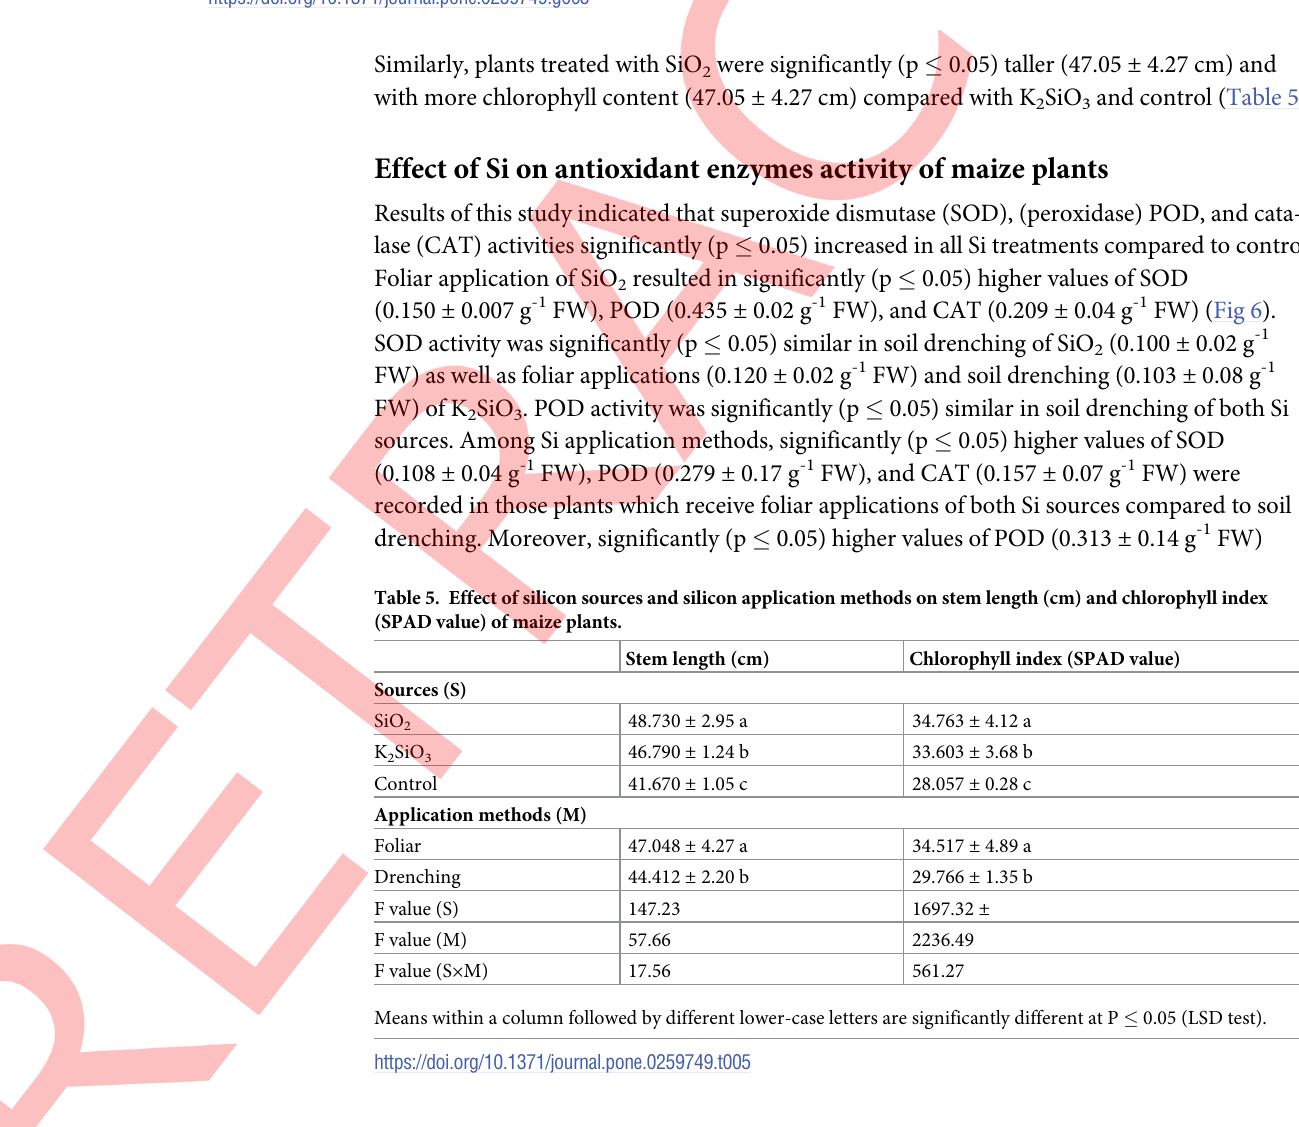
Fig 5. Effect of Si sources and Si application methods on (a) stem length (cm) and chlorophyll content (SPAD value) of maize. Bars with different lower-case letters are significantly different; LSD test at p � 0.05. Vertical bars indicate SD.